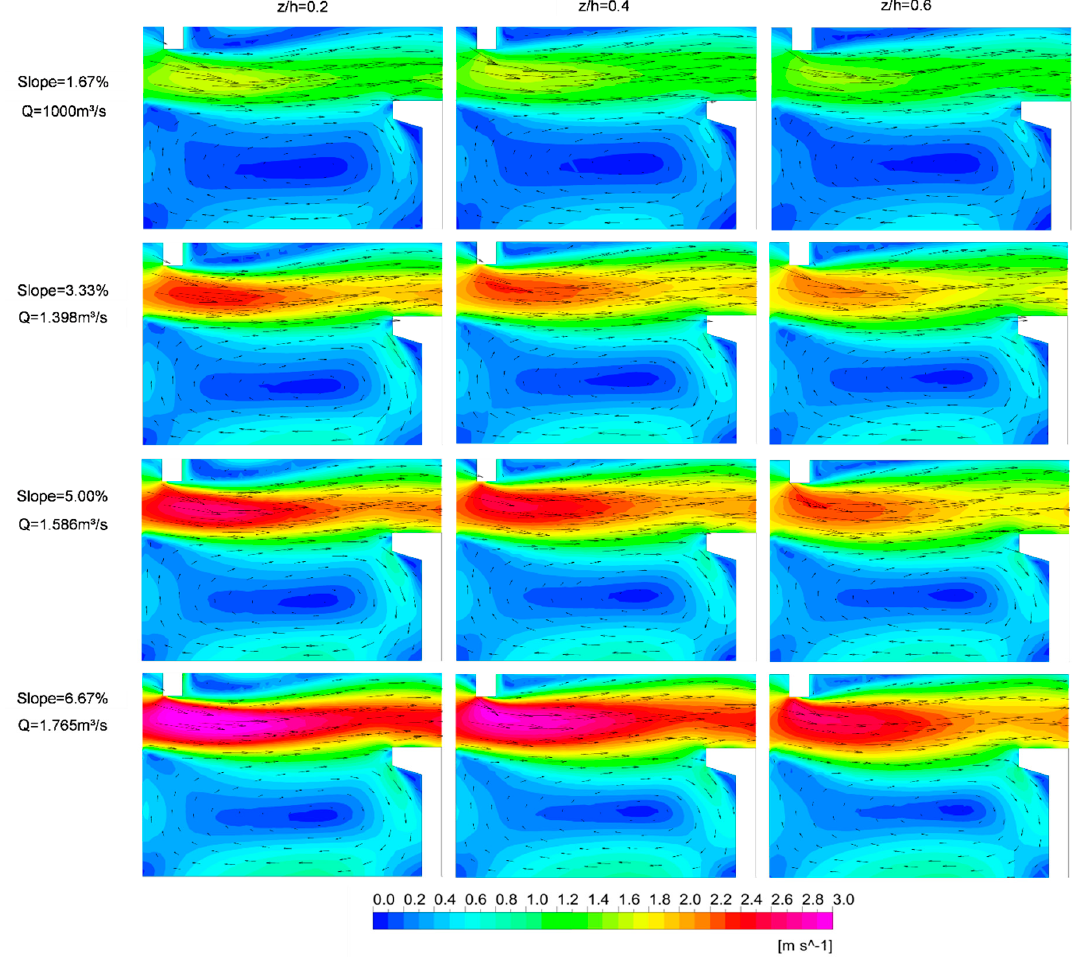
Figure 4. Velocity fields (V) in different planes parallel to the bottom at a distance from it of z/h = 0.2, 0.4 and 0.6, for the four slopes tested in design D1.